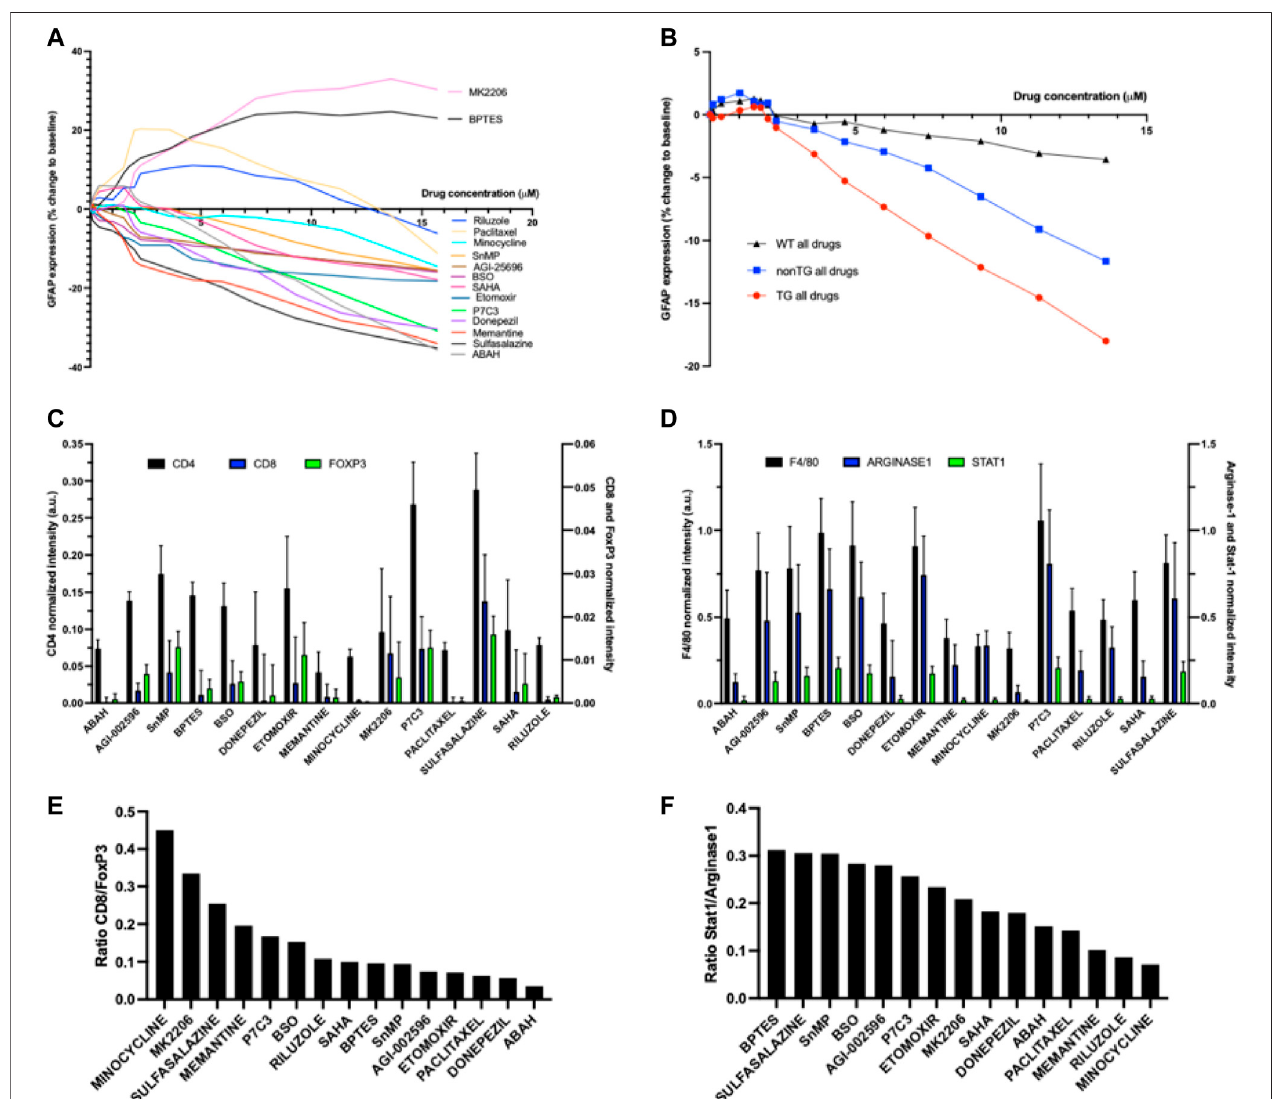
FIGURE 4 | (A) Precise PK/PD curves GFAP expression versus drug concentration for 15 individual drugs at 7 days (n = four to six per drug) (B) PK/PD for GFAP expression as a function of concentration for all drugs combined, compared across three animal models (C) and (D) Quantitative description of commonly used T-cell and macrophagemarkers, respectively,per individual drugregion(n=four tosixper drug) (E) Ratio ofCD8 toFoxP3ineach regionofdrugactivity tomeasure effects of each drug ’ s effect on T-cell state (F) Ratio of Stat1 to Arginase-1 FoxP3 in each region of drug distribution to measure each drug ’ s effect on macrophage